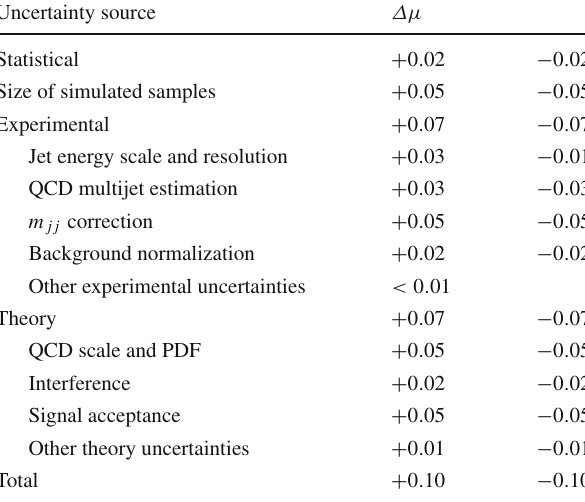
Table 2 Major sources of uncertainty in the measurement of the sig- nal strength μ , and their impact. The total uncertainty is separated into four components: statistical, number of simulated events, experimen- tal, and theory. The experimental and theory components are